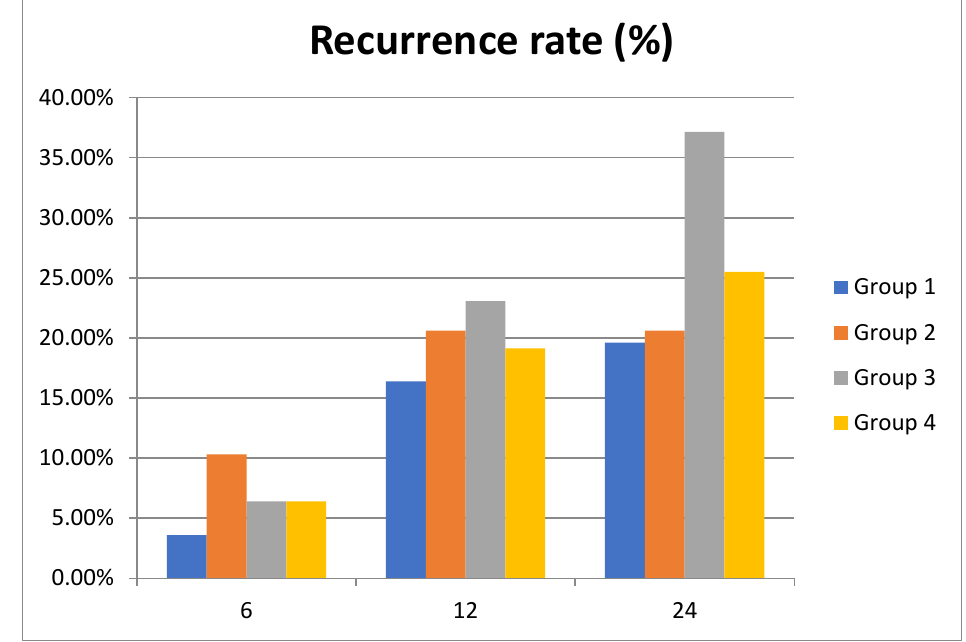
Table 5. Number of patients with PE recurrence.